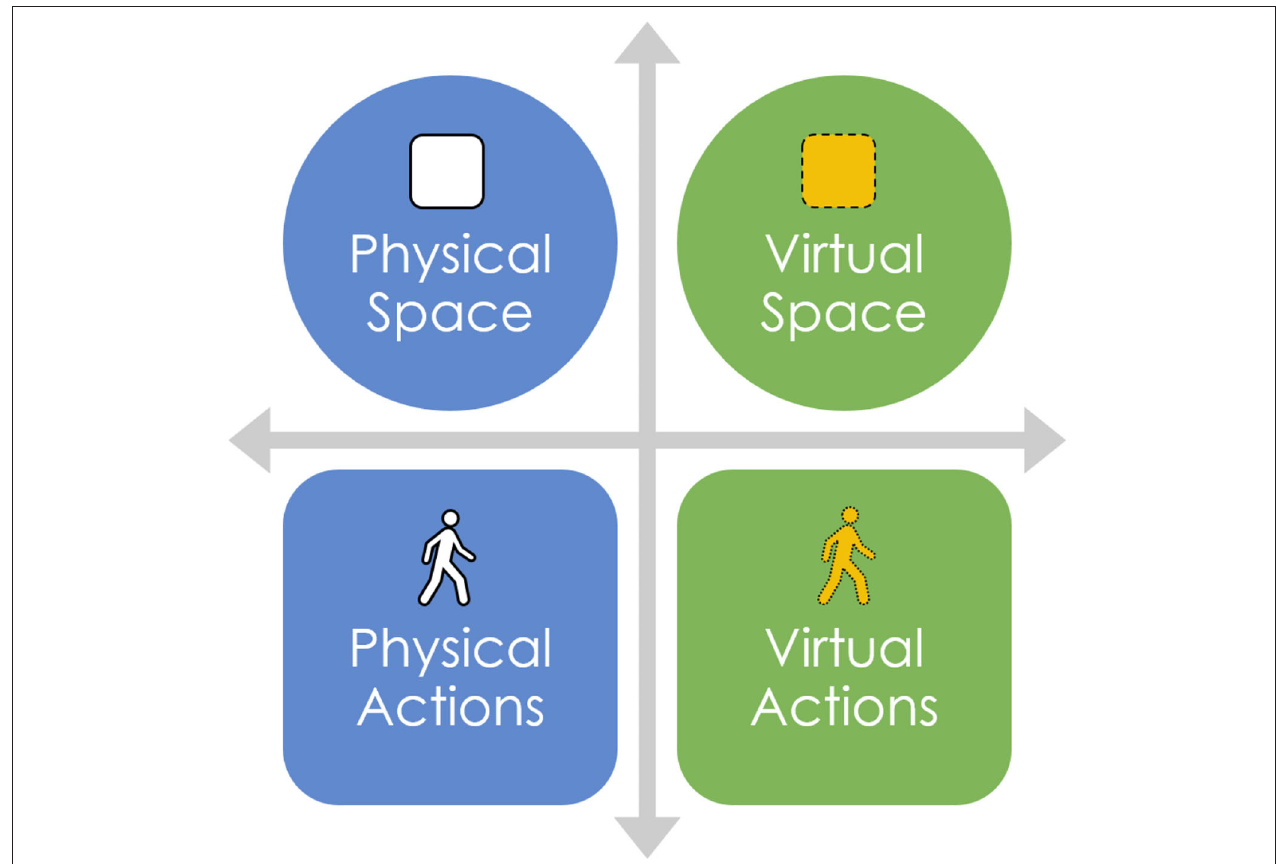
FIGURE 3 | Protean kinematics occurs at the intersection of physical affordances/actions and virtual affordances/actions. Here, we depict affordances as